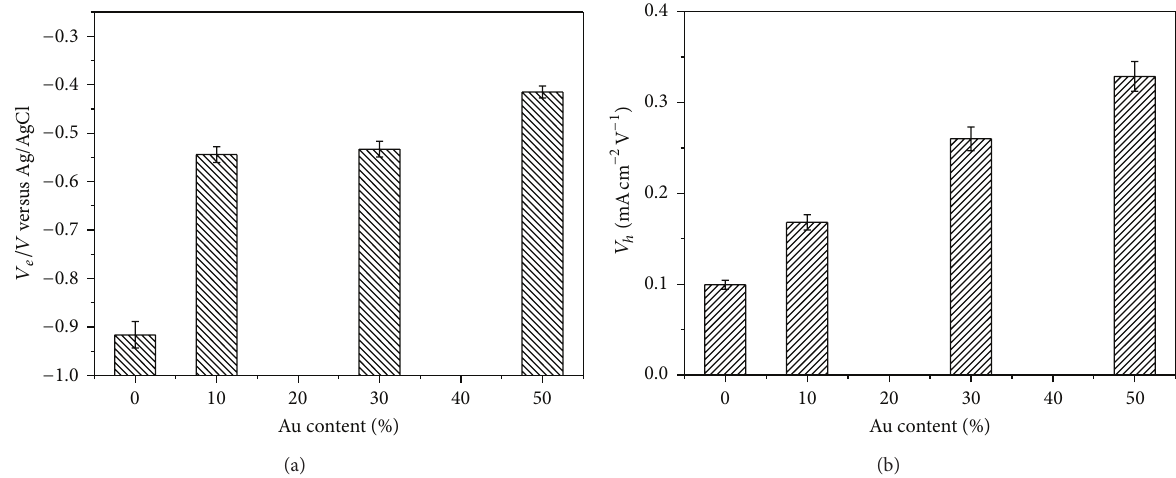
Figure 5: Variation of the estimated (a) 𝑉 𝑒 ; (b) 𝑉 ℎ values with the Au